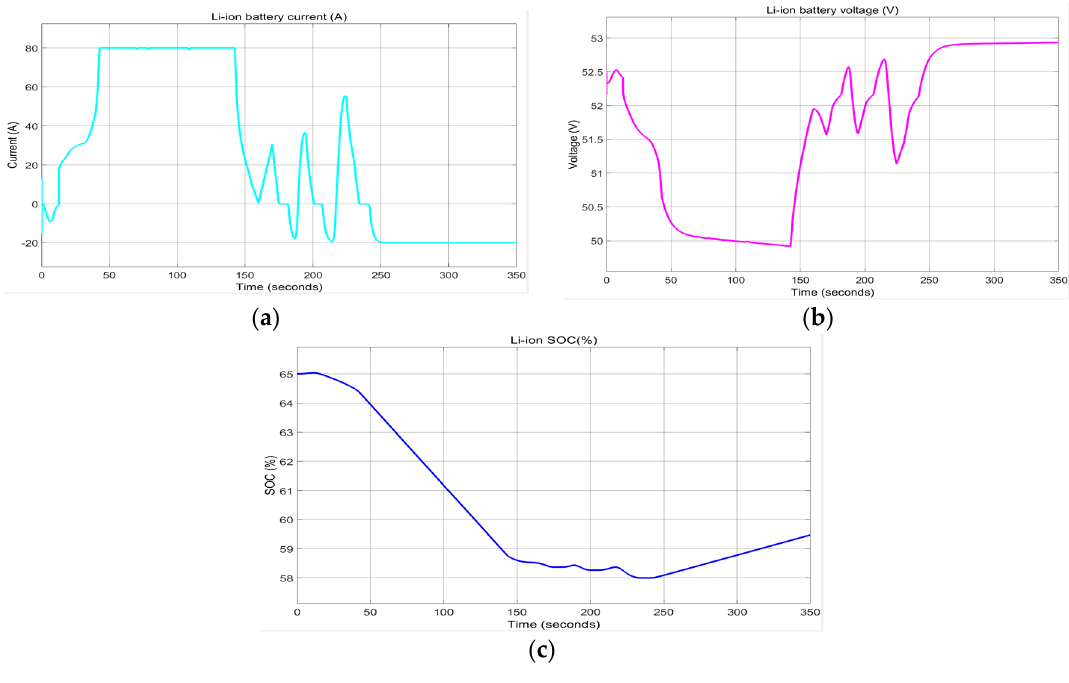
Figure A5. Li-ion battery specific variables. ( a ) Battery current; ( b ) Battery voltage; ( c ) Battery SOC.